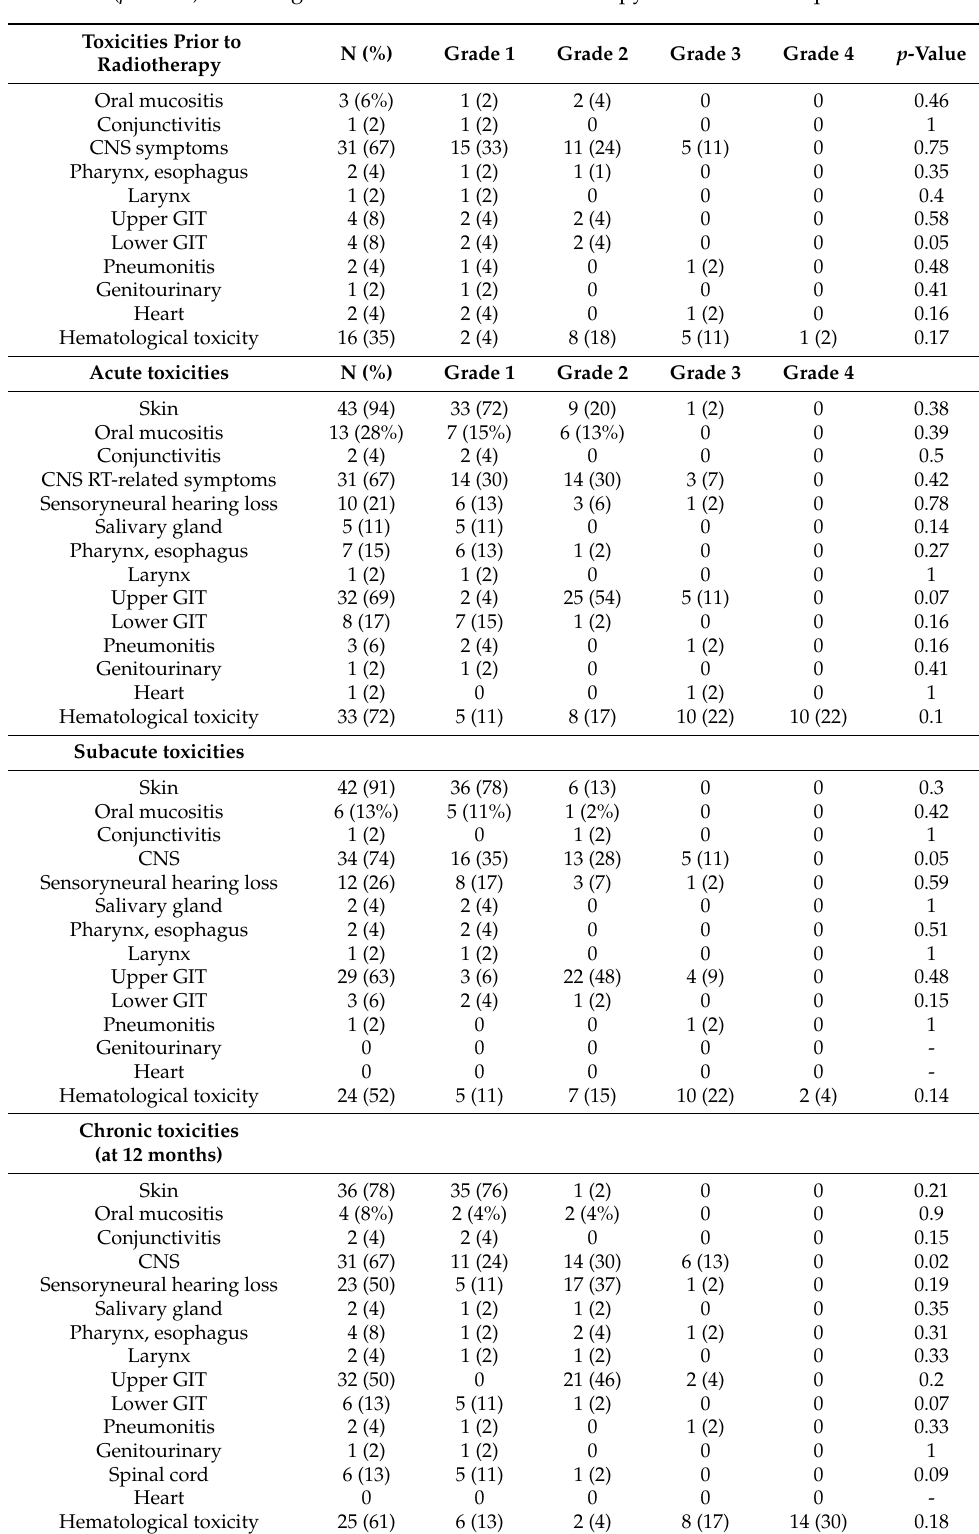
Table 2. Acute and late radiation reactions of medulloblastoma craniospinal irradiation and the difference ( p -value) according to conventional and Tomotherapy radiation